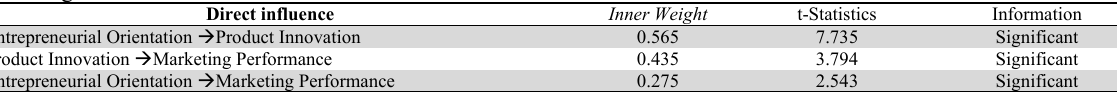
Inner weight Result Direct Effect